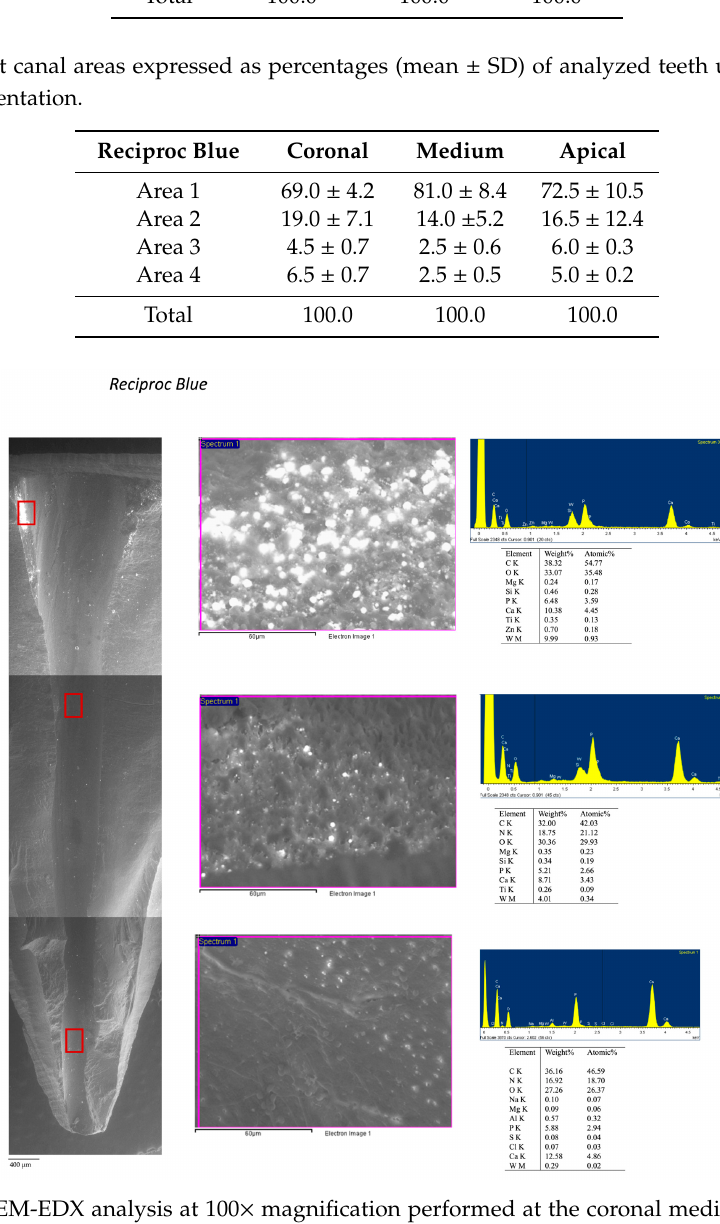
Figure 5. ESEM-EDX analysis at 100 × magnification performed at the coronal medium and apical third of root retreated using a RB instrumentation. Coronal third revealed some areas filled with high electron dense remnants. Medium and apical third presented few debris, dentin smear layer (Ca and P) and some open and clean (no smear plugs) dentinal tubules. EDX analysis performed at 3000 × magnifications on one area with electron dense remnants located at the coronal thread revealed a higher presence of Zn, Zr, and W, attributable to sealer and gutta-percha. Similarly, EDX at 3000 × magnifications in one area located at the medium third with fewer electron dense debris revealed reduced presence of elements attributable to sealer (W). EDX at one area at the apical third revealed